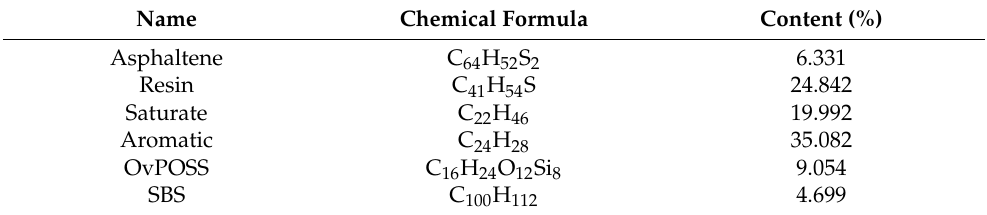
Figure 6. Nano-OvPOSS/SBS modified asphalt models with different nano-OvPOSS diameters: ( a ) 5 Å nano-OvPOSS; ( b ) 7 Å nano-OvPOSS; ( c ) 9 Å nano-OvPOSS. Table 5. Detailed information of modified nano-OvPOSS/SBS asphalt system.